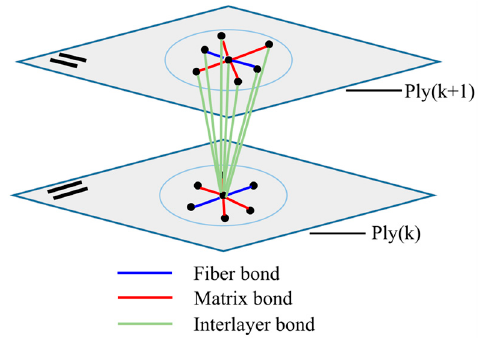
Figure 7. PD model of a composite laminate.